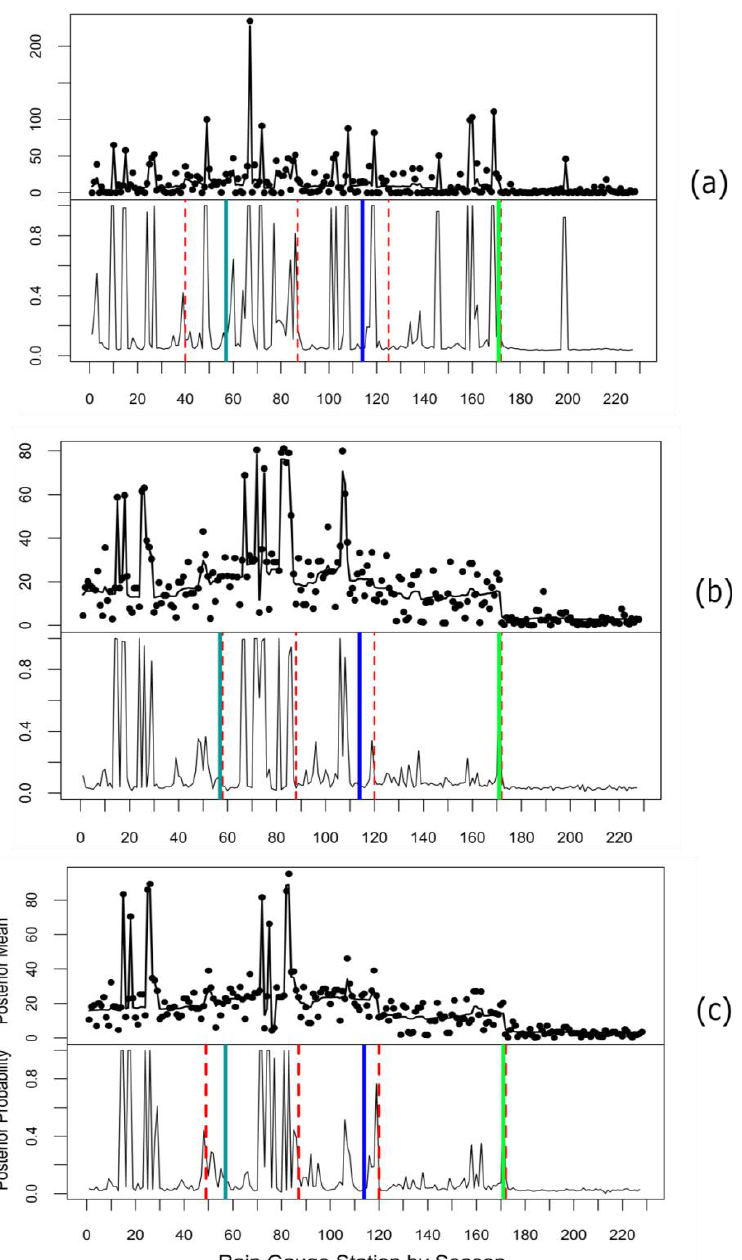
Figure 11. Bayesian change point (bcp) and nonparametric approach for multiple change point analysis (ecp) results for 2017 (seasonal accumulation) for ( a ) OBSERVED, ( b ) TRMM, and ( c ) GPM. The solid lines show the original seasonal partitioning season (the teal color indicates when DJF (winter) ends and spring (MAM) begins, the blue color when spring ends and summer (JJA) begins, and green when summer ends and autumn (SON) begins). The dash red lines show the change points derived using both bcp and ecp. The X -axis indicates the total number of rain-gauge stations (57) used, meaning each partition (solid line and season) has 57 stations.